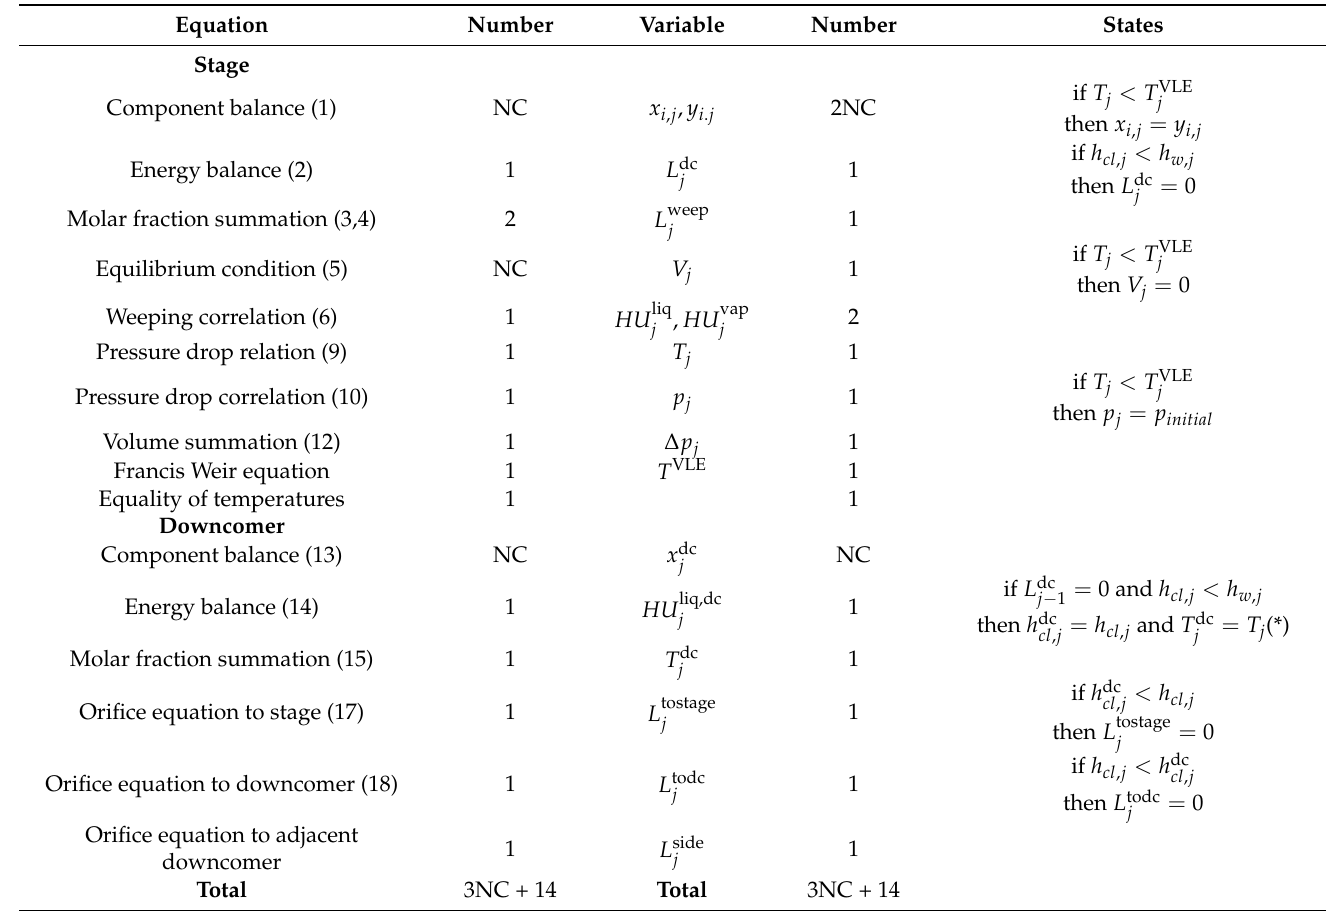
Table A1. List of equations, variables and states within the equilibrium stage model with